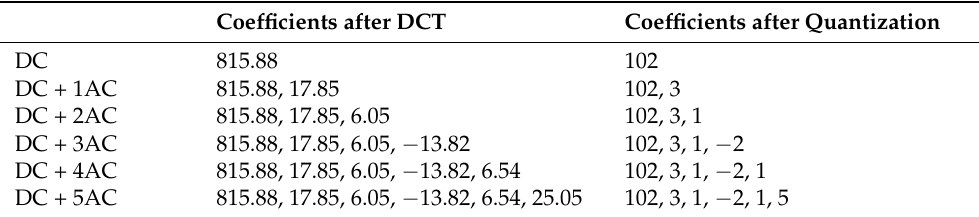
Table 2. Extract 12 combinations of coefficients from Table 3. Each set consists of a DC component with a certain number of AC values, which were retrieved either after DCT or after quantization.